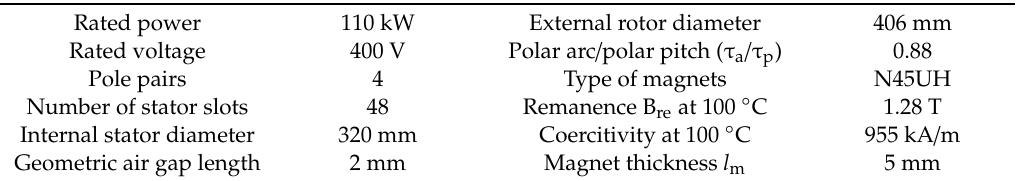
Figure 4. Air gap flux-density due to the 1st phase of armature for an 8-poles, 3- ph PM motor with ε = 0.25; α λ = π / 2. Table 1. Main motor